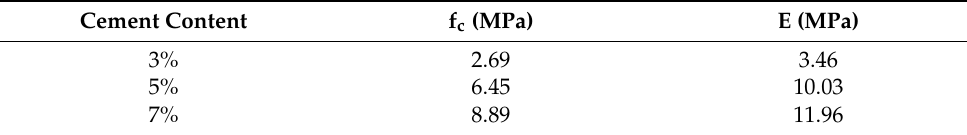
Table 1. Mechanical characteristics of the CBGM. Cement